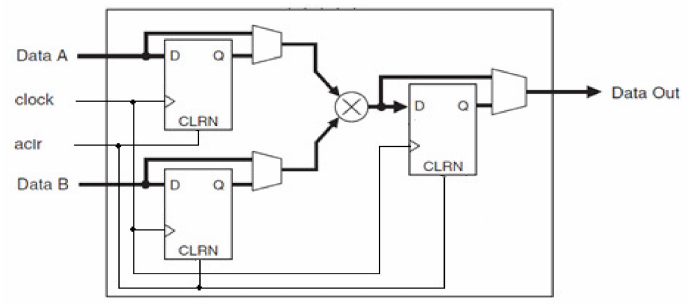
Figure 1. The structure of the built-in 9 bit multiplier.